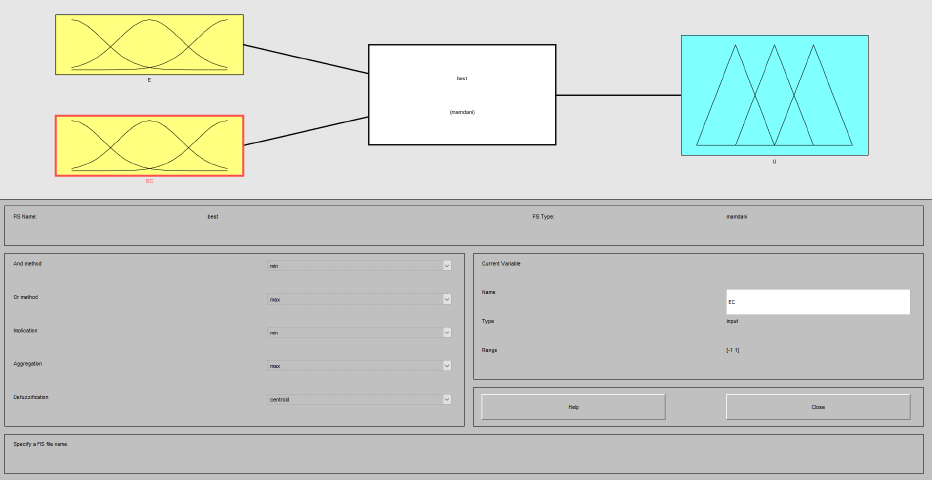
Figure 9. Form of